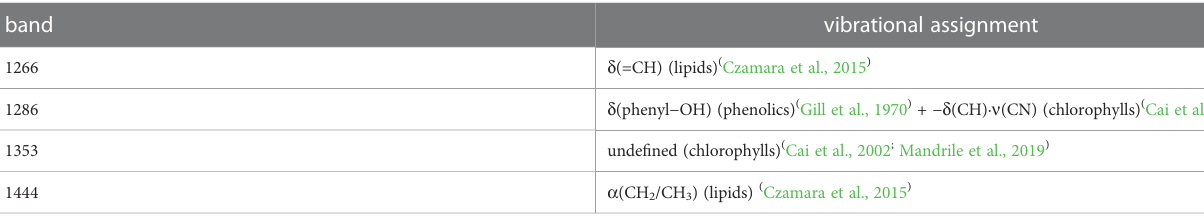
TABLE 1 Vibrational Bands and Their Assignments for Pear Leaf